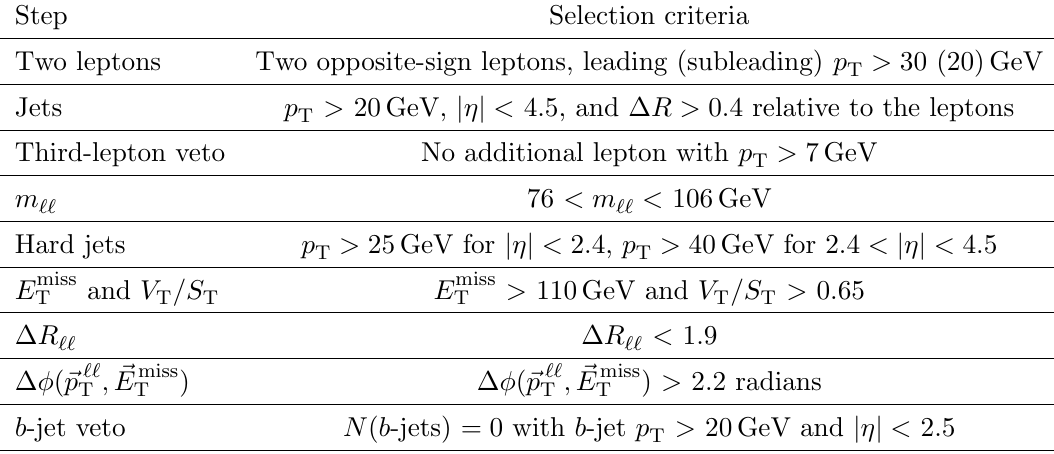
Table 2 . Event selection criteria for the ‘‘(cid:23)(cid:23) signature.